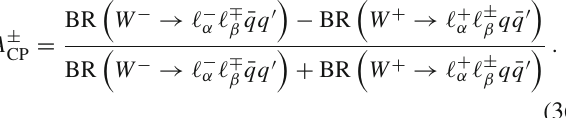
Notice that a similar computation was performed in